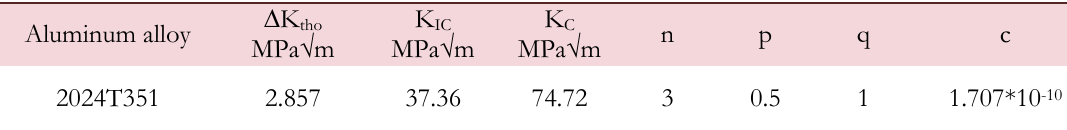
Table 2: Propagation model parameters useful by the NASGRO model (AFGROW